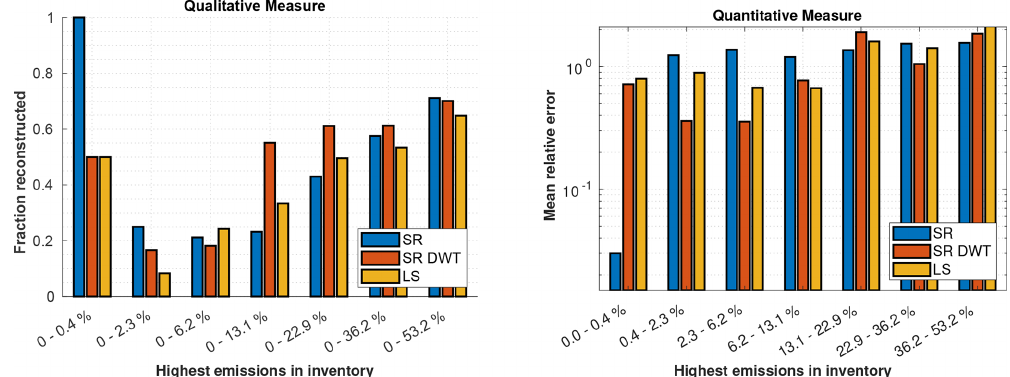
Figure 11. Qualitative and quantitative measure of how well SR and LS estimate the highest emissions with a noise of 20dB for Munich. The qualitative plot shows how many percent of the highest emissions in the inventory are also contained in the same highest amount of emission of the reconstruction. The quantitative plot shows the mean relative errors for different emission